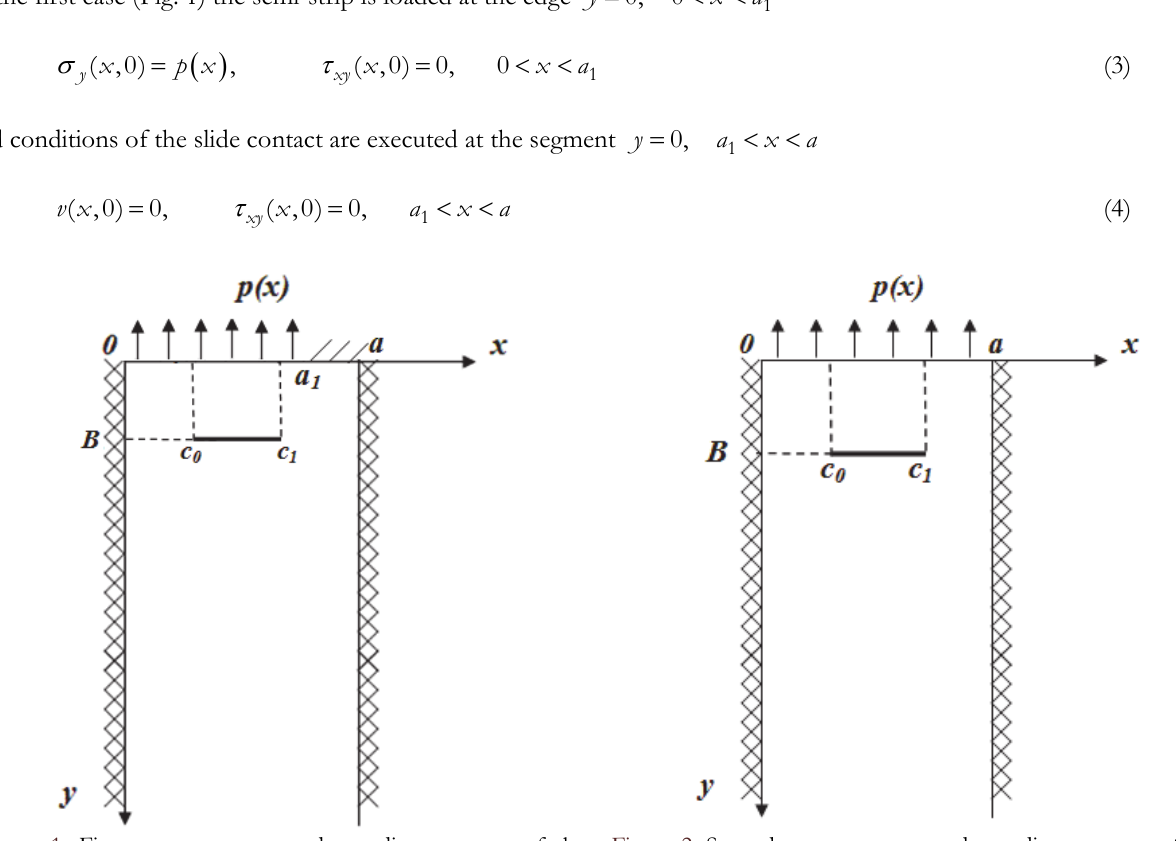
Figure 2: Second case: geometry and coordinate system of the